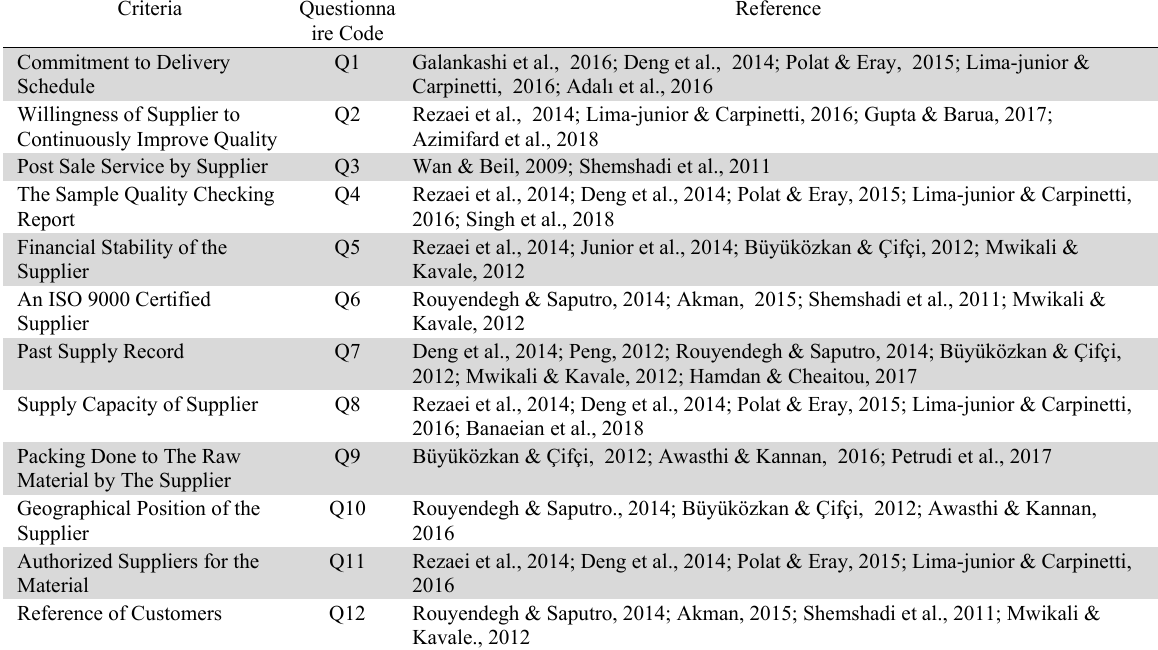
Literature on criteria for supplier